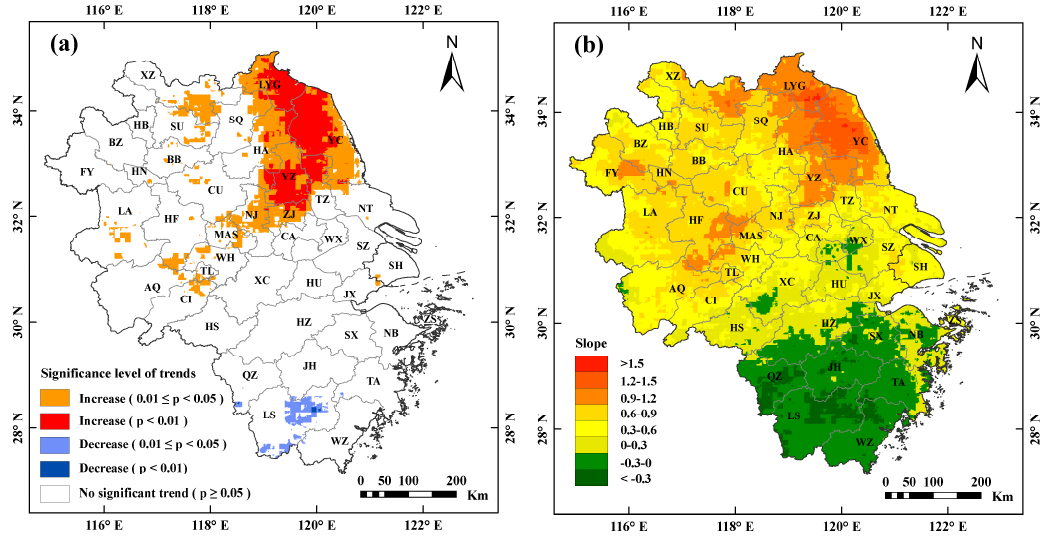
Figure 3. Trends in PM 2.5 concentrations during 2002–2017 period: ( a ) significance level of trends (increase means slope >0 and decrease means slope <0); and ( b ) slope values.